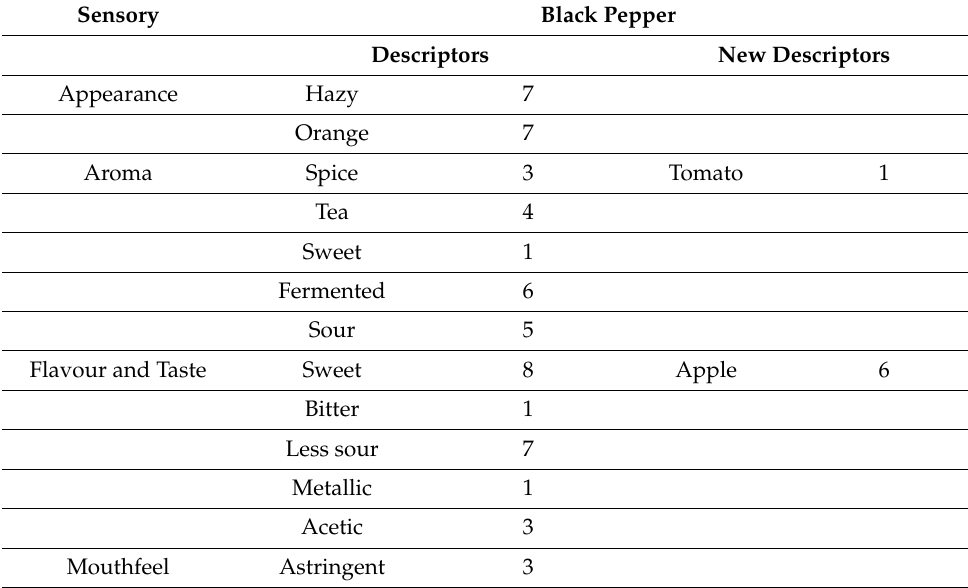
Table 4. The results from the sensory focus group of eight panellists. The descriptors were based on the commercial Kombucha beverages, and the new descriptors were from the black pepper Kombucha